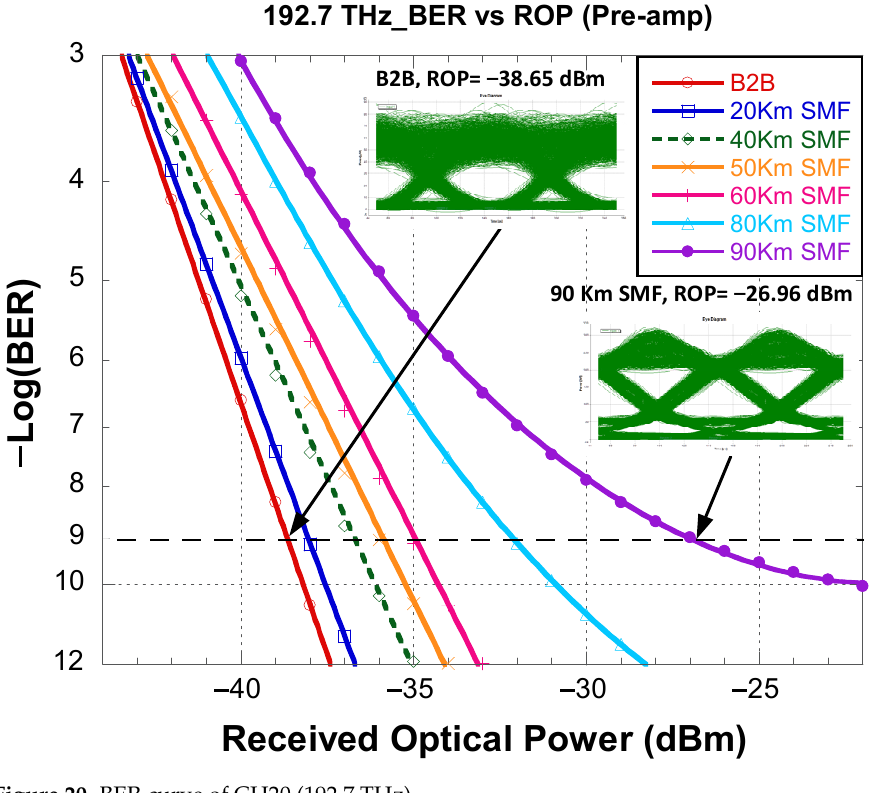
Figure 20. BER curve of CH20 (192.7 THz).